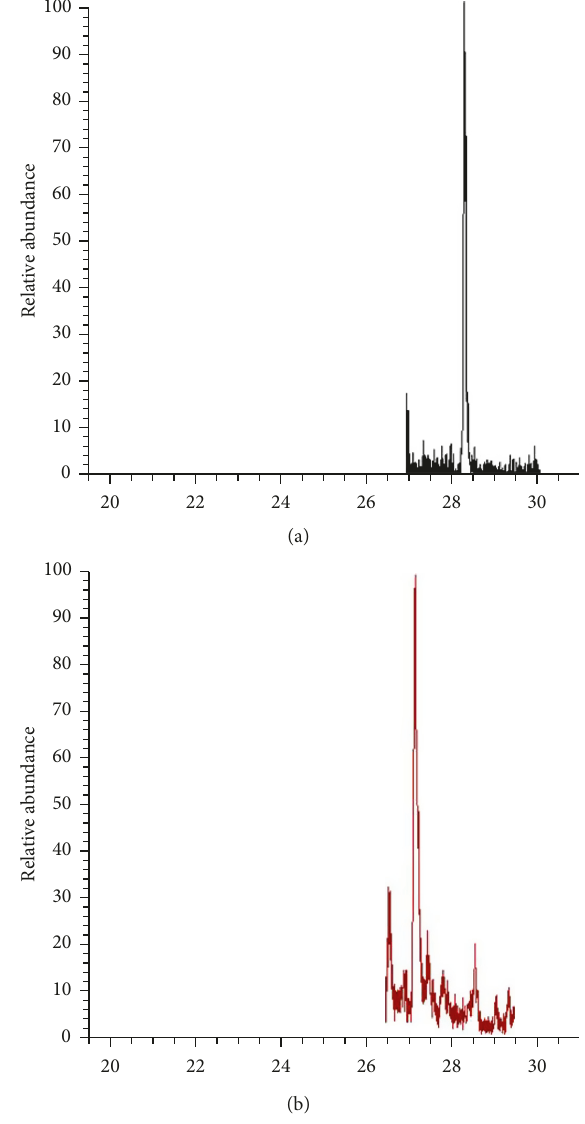
Figure 5: False-positive detection of diclofenac in wastewater. The calculated ion ratio, 0.15, falls outside the ion ratio tolerance range of 1.57 to 3.67. The chromatograms show (a) the peak for the quantitative ion with a transition of 296 the qualitative ion with a transition of 296